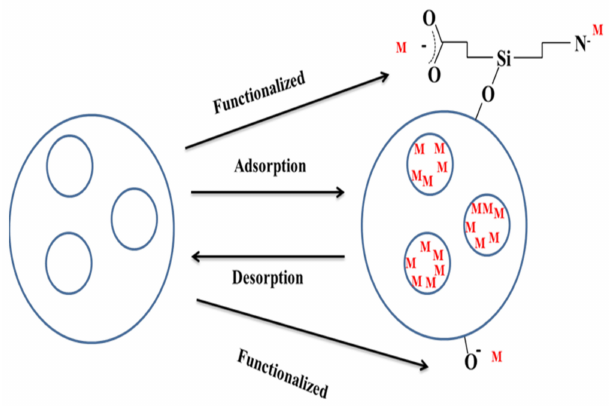
Figure 4. Adsorption sites of a mesoporous silica nanoparticles and functionalization with differ- ent groups.